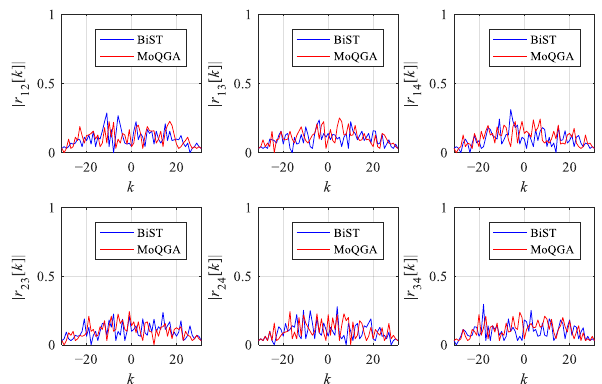
Figure 18. Cross-correlation functions of the waveform set obtained by MoQGA and BiST under M = 4, N = 32, and K = 4.